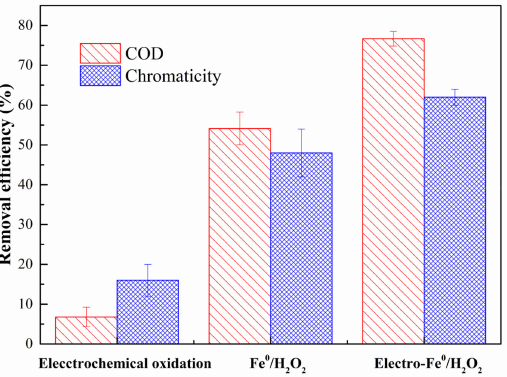
Figure 4. Comparison of electrochemical oxidation, Fe 0 /H 2 O 2 , and electro-Fe 0 /H 2 O 2 for COD and chromaticity removal efficiency from coagulated effluent. Conditions: pH 0 = 3.0, current density = 5 mA/cm 2 , Fe 0 dosage = 3 g/L, H 2 O 2 dosage = 0.059 M, and reaction time = 180